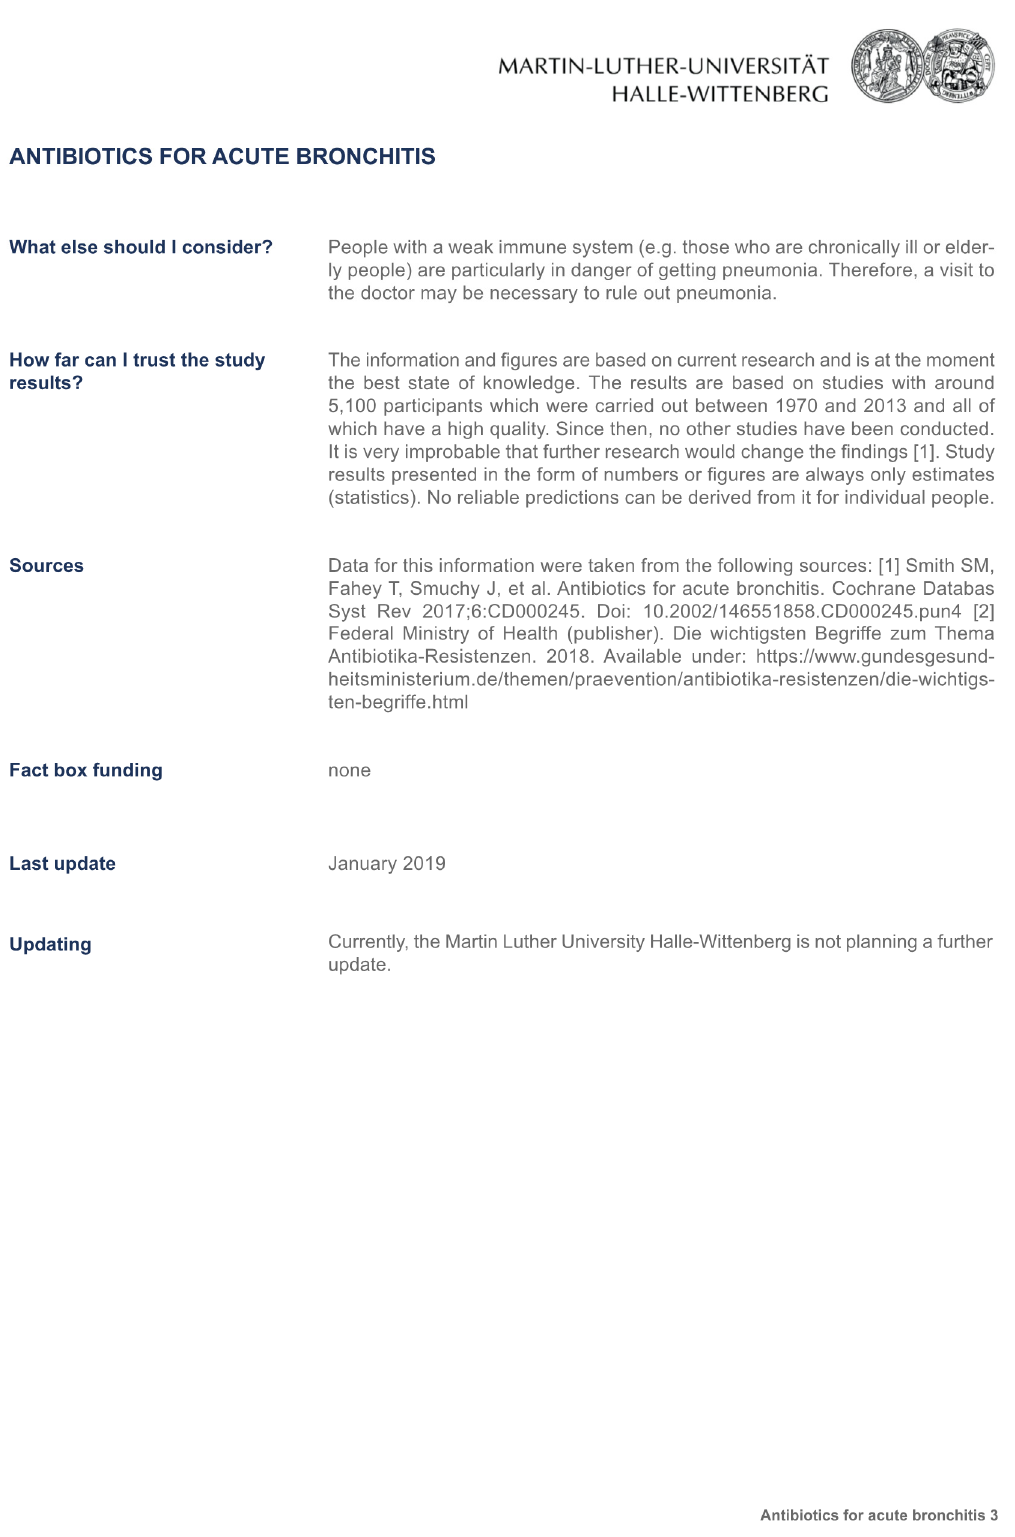
Figure 4. Fact boxes with additional information.